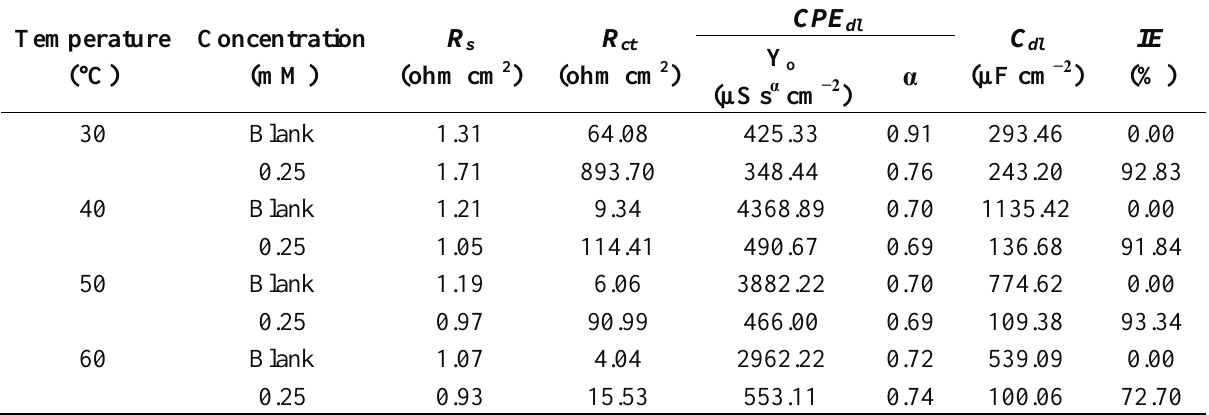
Table 2. Data for the CPE matching for mild steel in 1.0 M H corrosion inhibitor at different